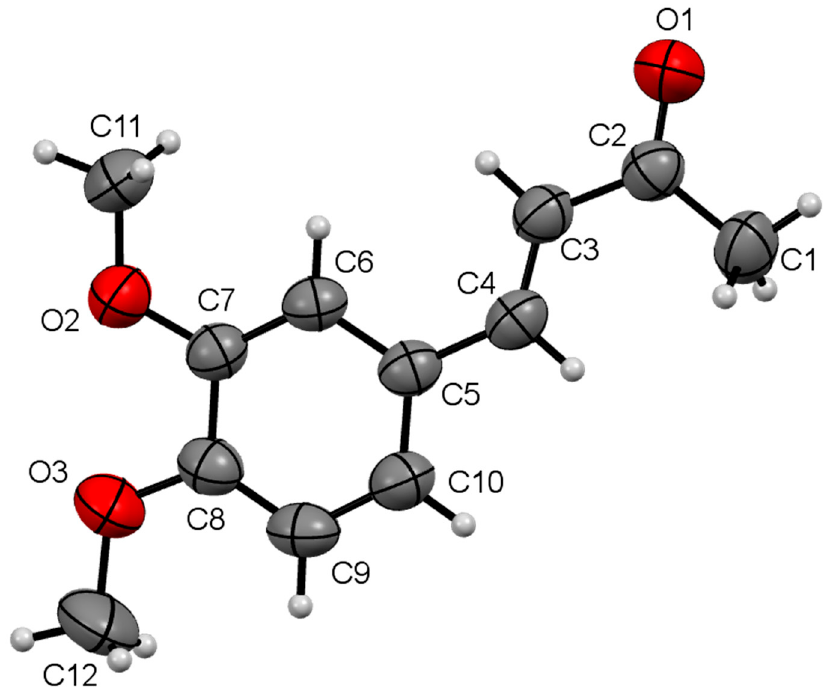
Figure 1. The ORTEP drawing of the molecule of compound I with displacement ellipsoids drawn at the 50% probability level.